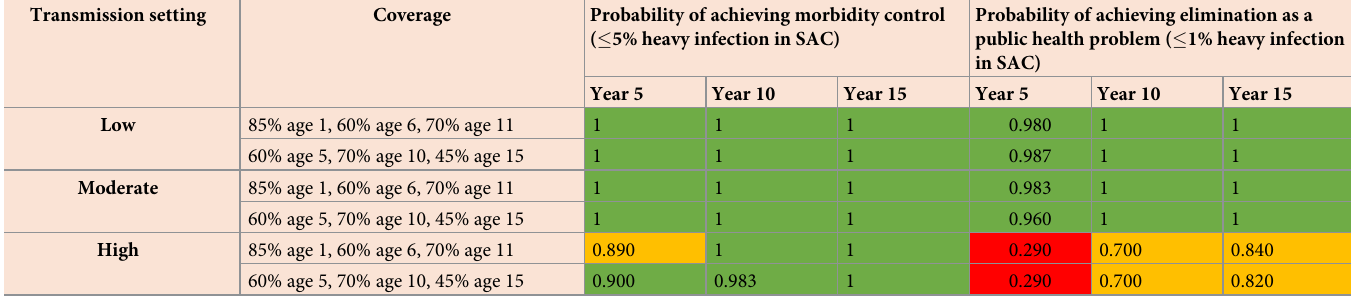
Table 8. MDA, 75% coverage in SAC (annually in high settings, once every 2 years in moderate settings and once every 3 years in low settings) and vaccine duration of protection is set at 5 years. Green shaded areas = probability of reaching target > 90%, Yellow shaded areas = 0.5 � probability of reaching target < 0.9, Red shaded areas = probability of reaching target <